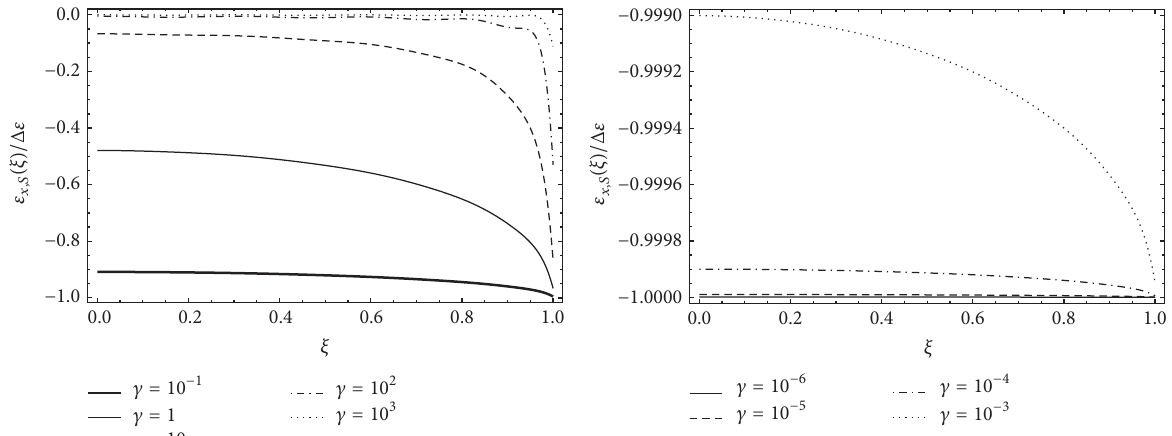
Figure 4: Longitudinal strain field for symmetric loading